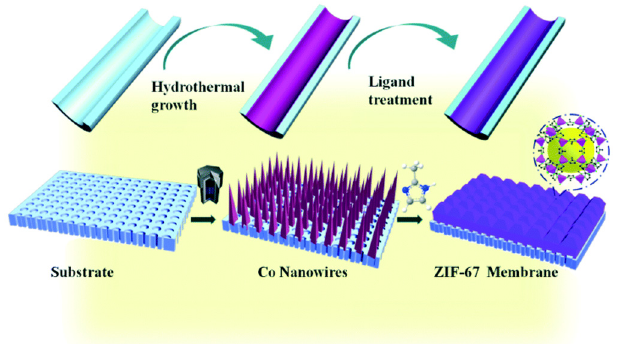
Figure 3. Schematic illustration of the preparation of a pure ZIF-67 membrane by self-conversion of carbonate hydroxide nanowire arrays (Co-NWAs). Reprinted with permission from [53], The Royal Society of Chemistry, Copyright (2018).